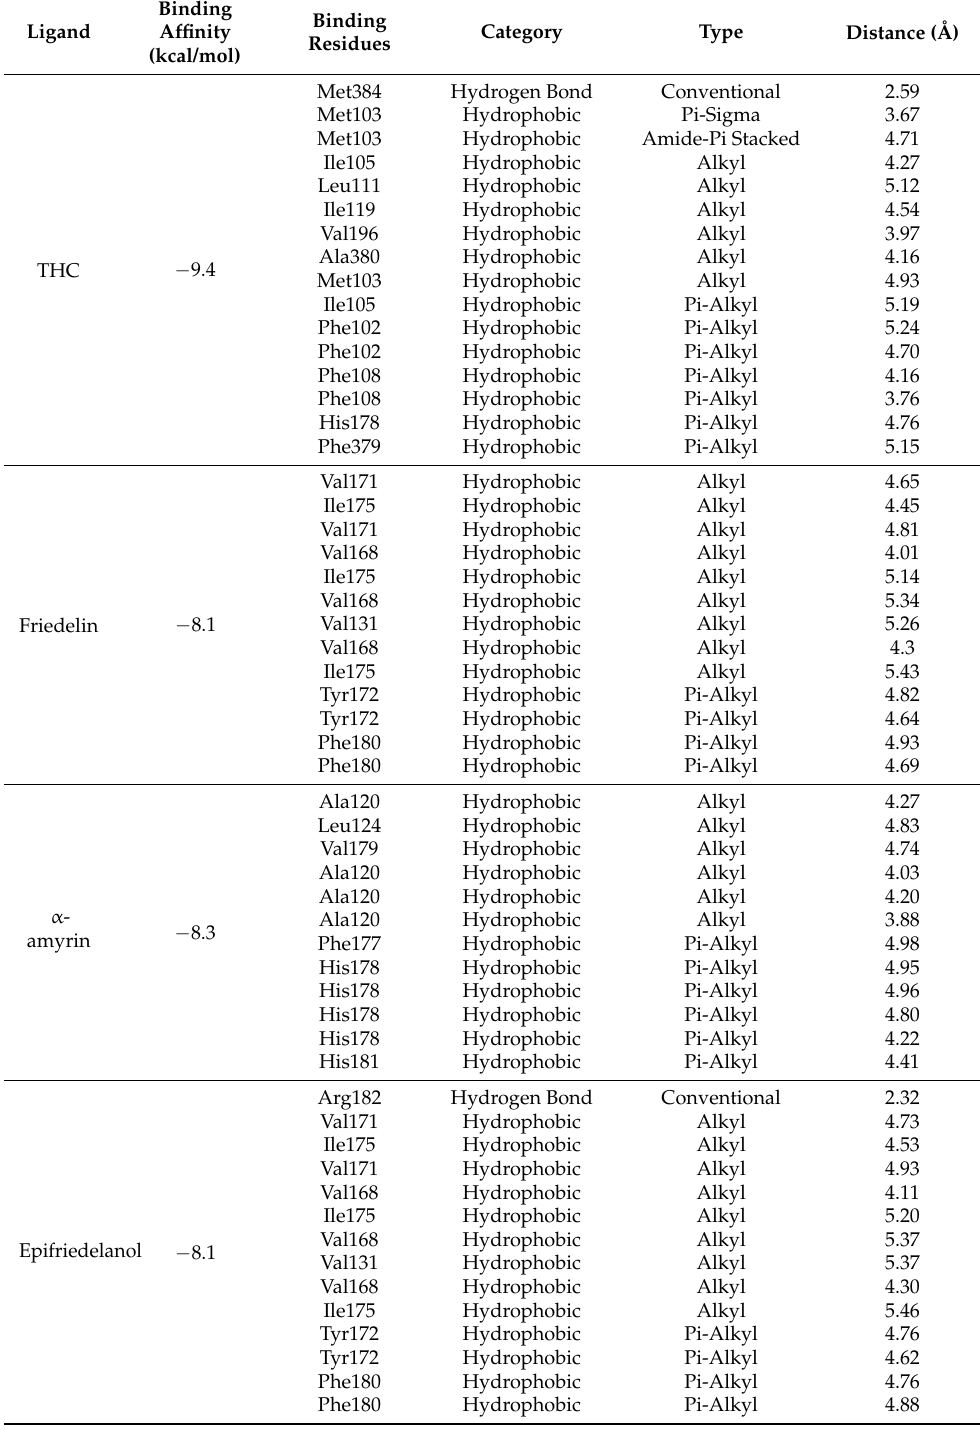
Table 2. Intermolecular interactions of THC, epifriedelanol, friedelin, and α -amyrin with